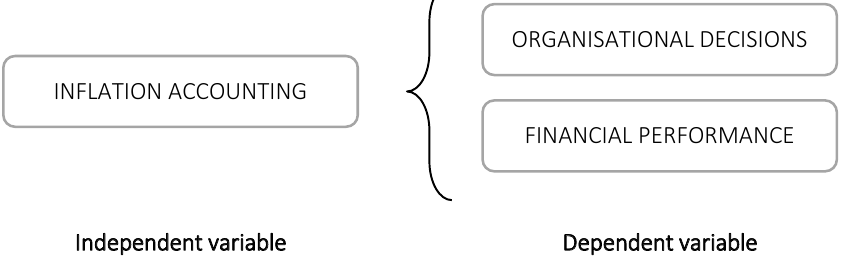
Figure 1. Conceptual